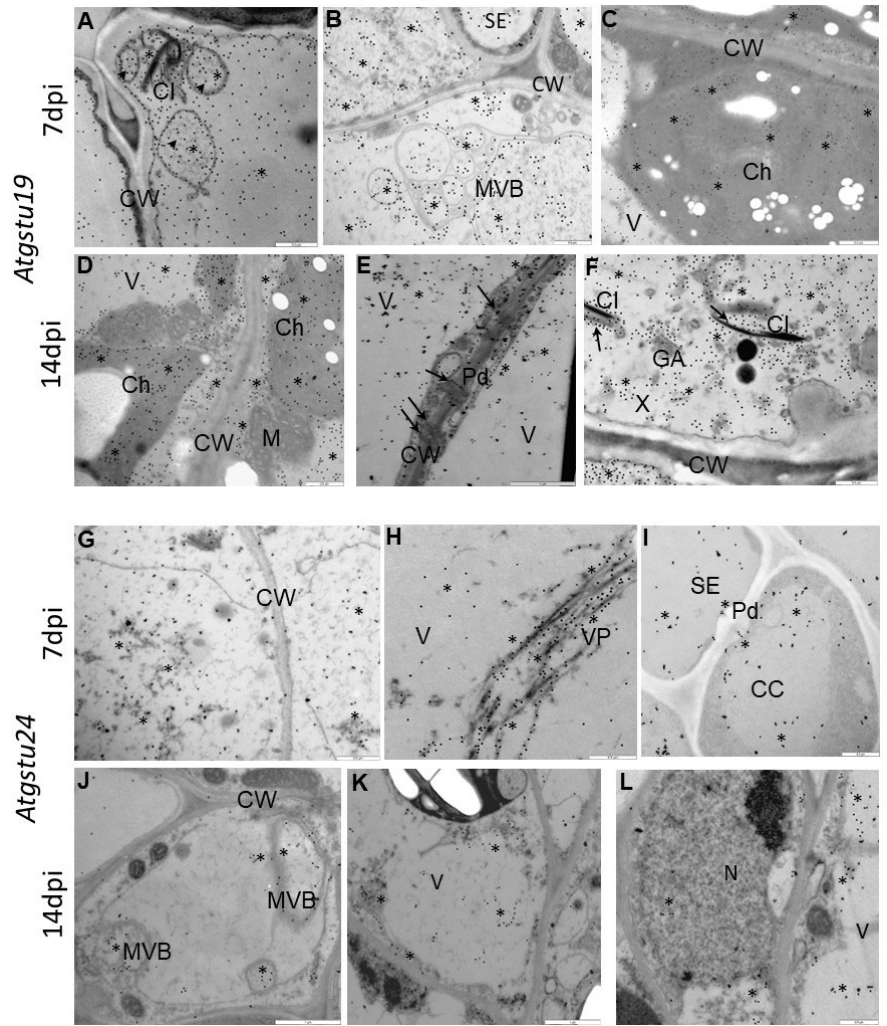
Figure 3. Immunogold labeling of TuMV in Atgstu19 ( A – F ) and Atgstu24 ( G – L ) 7 ( A – C , G – I ) and 14 ( C – E , J – L ) days after inoculation. ( A ) TuMV epitope deposition (*) round cytoplasmic virus inclusions (CI) and vesicular structures (arrowheads) in pallisade mesophyll cell. Scale bar 0.5 μ m. ( B ) TuMV epitope deposition (*) in multivesicular bodies (MVB) of phloem parenchyma cells. TuMV eptope deposits in cytoplasm and vacuole (V). Scale bar 0.5 μ m. ( C ) Gold particles (*) in chloroplasts (Ch) and vacuole (V). Scale bar 0.5 μ m. ( D ) TuMV epitope deposition (*) indicating TuMV presence in chloroplasts (Ch), along the cell wall (CW) and in vacuole (V). Scale bar 0.5 μ m. ( E ) TuMV epitope deposition (*) along cell wall (CW) and inside plasmodesmata (Pd, arrows) between phloem cells. Scale bar 1 μ m. ( F ) TuMV epitope deposition (*) inside xylem tracheaery elements. Virus inclusions (CI, arrows) inside xylem tracheary element (X). Scale bar 0.5 μ m. ( G ) TuMV epitope deposition (*) in cytoplasm of mesophyll cell. Scale bar 0.5 μ m. ( H ) TuMV epitope deposition (*) along virus particles (VP) in vacuole (V) of mesohyll cell. Scale bar 0.5 μ m. ( I ) TuMV epitope deposition (*) in sieve element (SE) and vacuole (V) of phloem cells. Scale bar 0.5 μ m. ( J ) TuMV (*) around multivesicular bodies (MVB) in phloem cell. Scale bar 1 μ m. ( K ) TuMV epitope deposition (*) in vacuole (V) of phloem parenchyma cells. Scale bar 1 μ m. ( L ) TuMV epitope deposition (*) in vacuoles of spongy mesophyll cell. A few gold granules in nucleus (N). Scale bar 0.5 μ m. CC—companion cell, GA—trans ‐ Golgi network, Pd—plasmodesmata, SE—sieve elements, X—xylem tracheary elements.